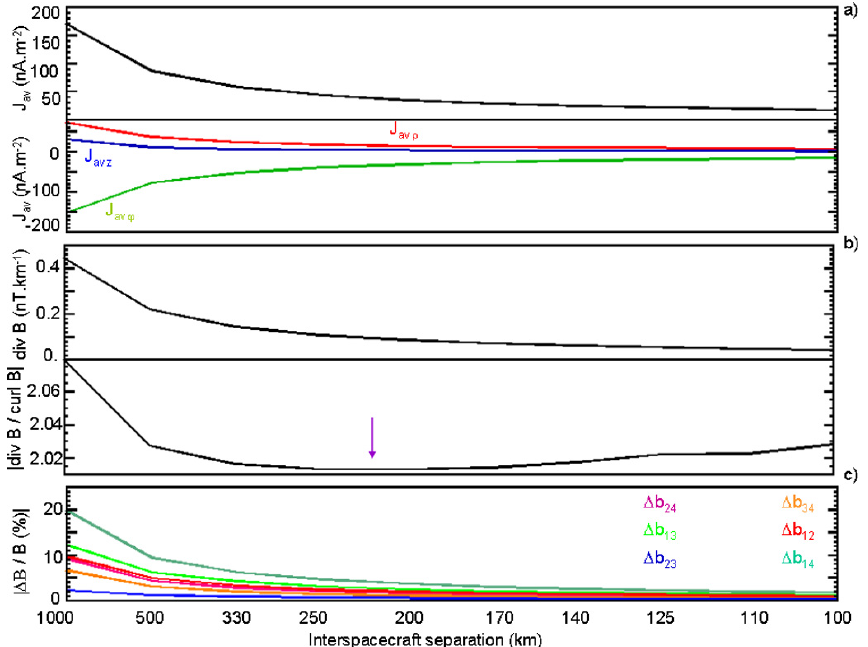
Fig. 10. J av , its components (frame a ), div B (frame b ), div B (cid:14) curlB (frame b ), and 1b ij (frame c ) versus the interspacecraft separation distance. The violet arrow is located at about 220km separation distance. For this value, the best accuracy of the curlometer has been